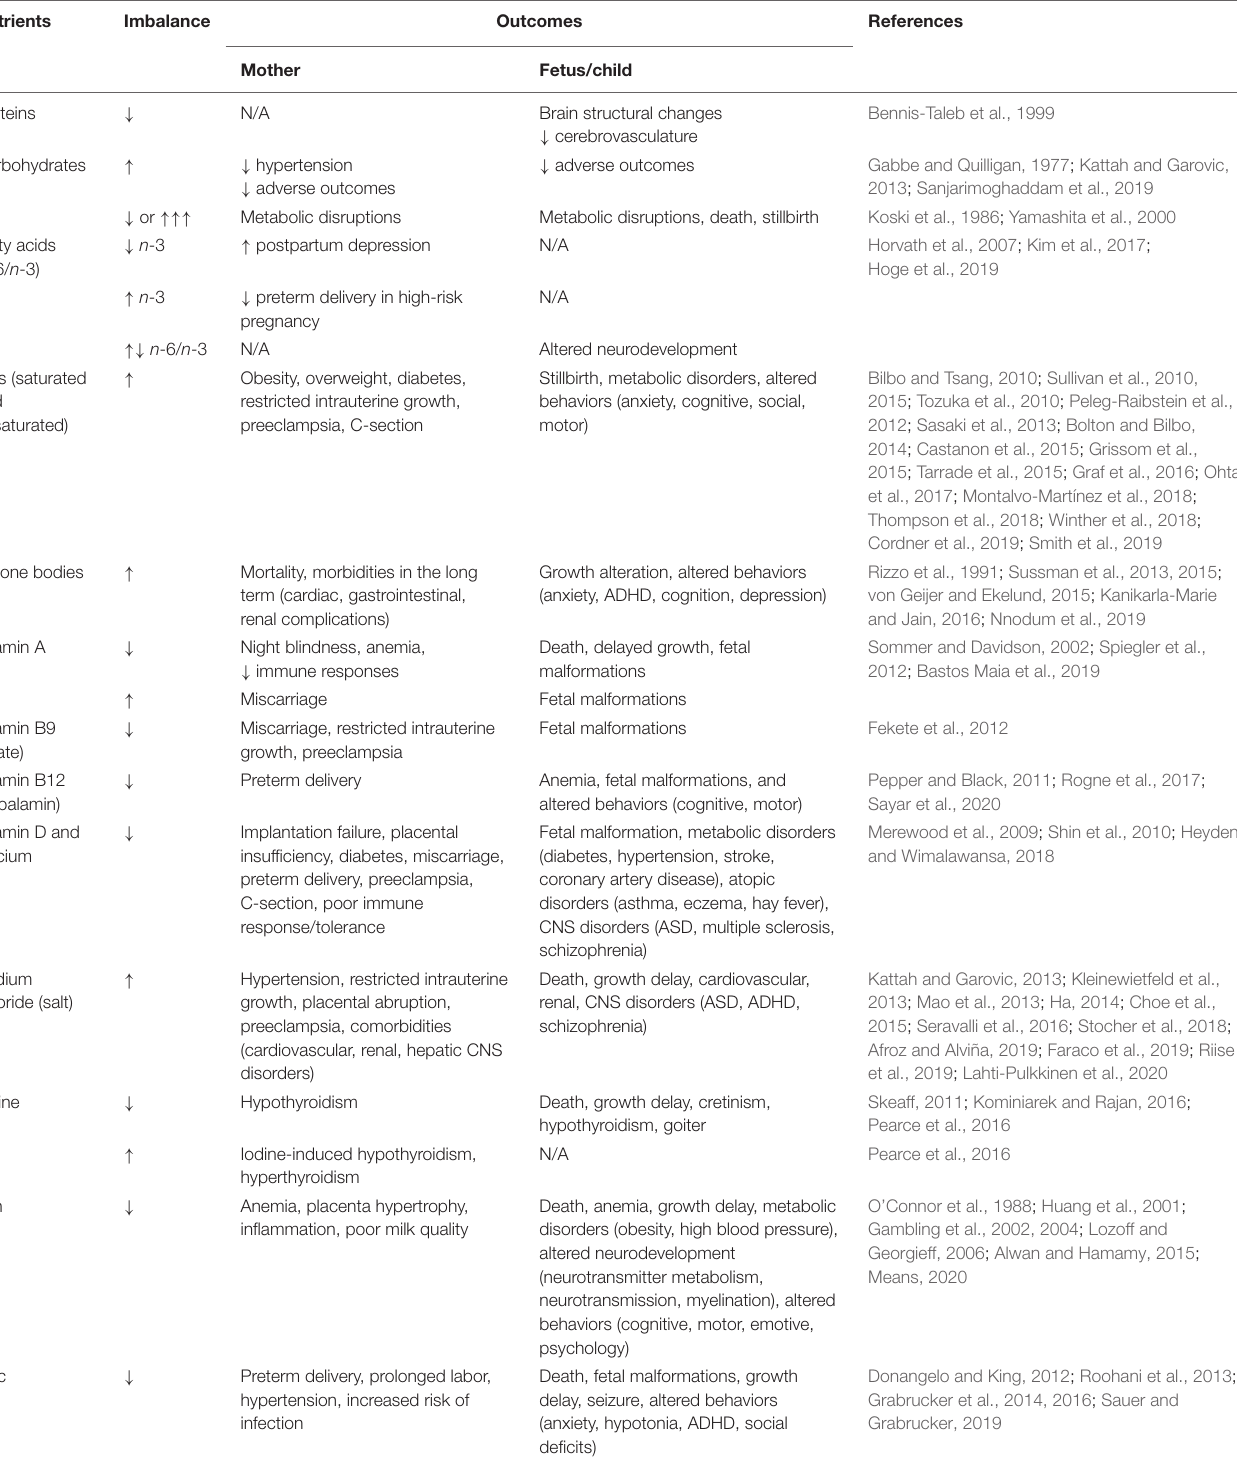
TABLE 2 | Maternal and fetal outcomes of essential nutrient